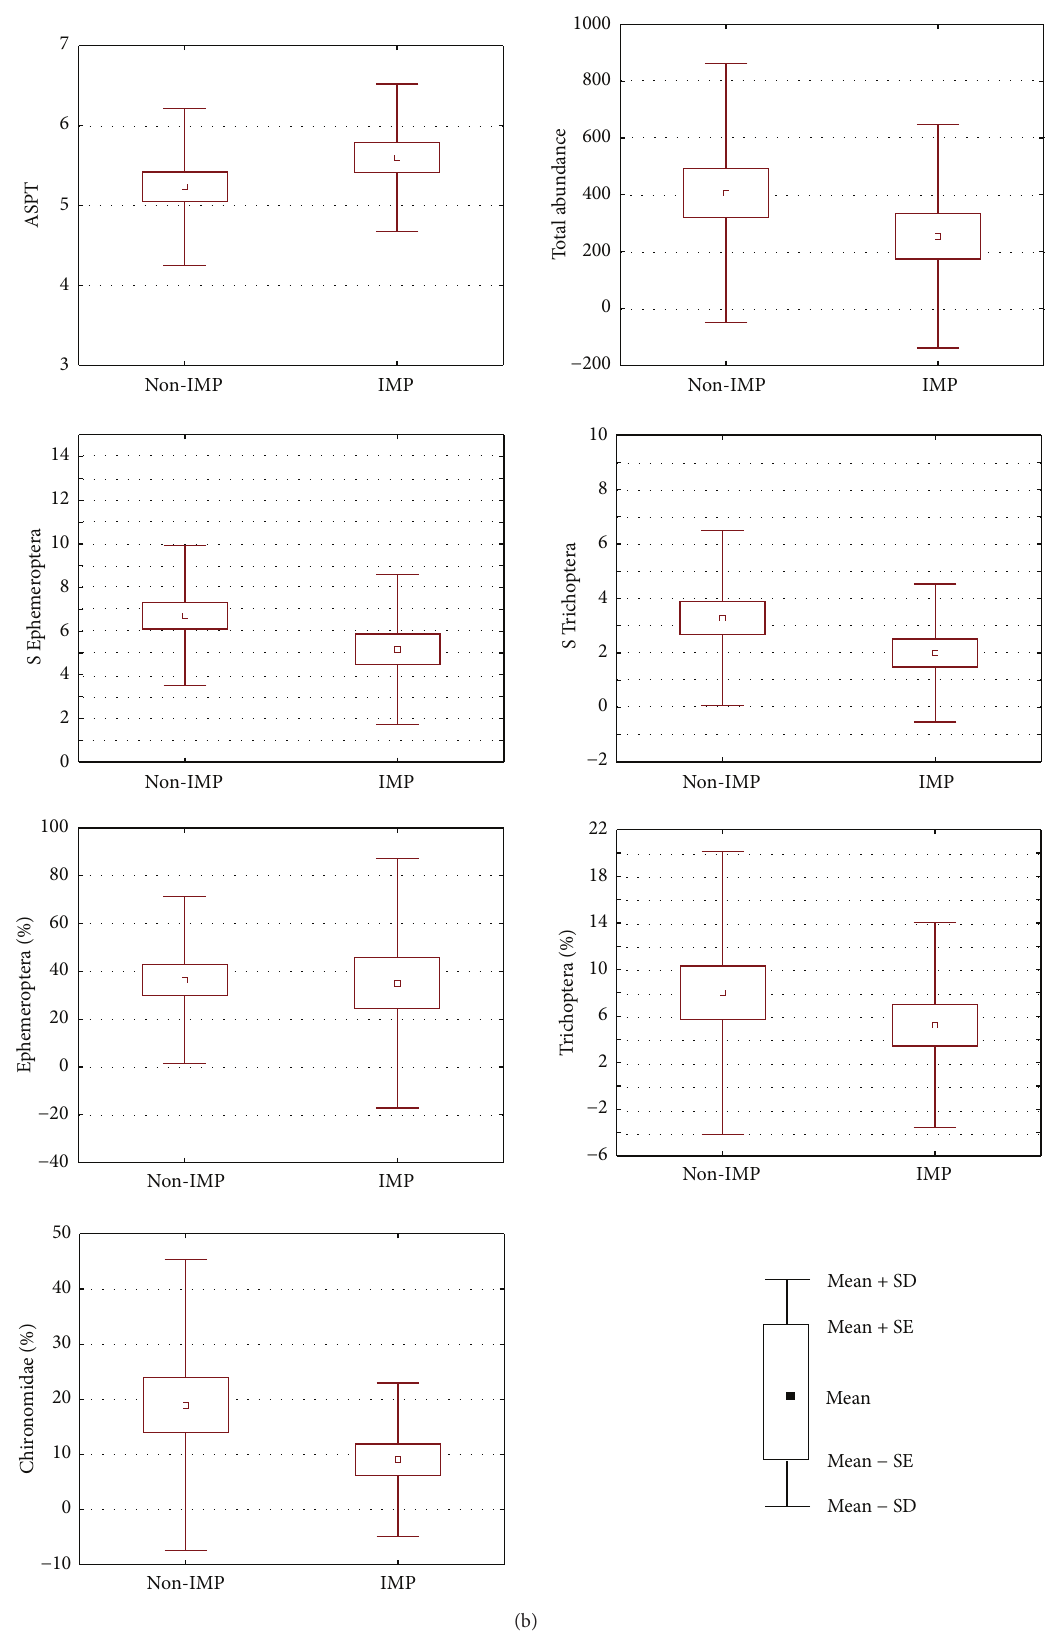
Figure 2: Response of several analyzed metrics to human impact on the studied streams. S: richness; %: percentage of